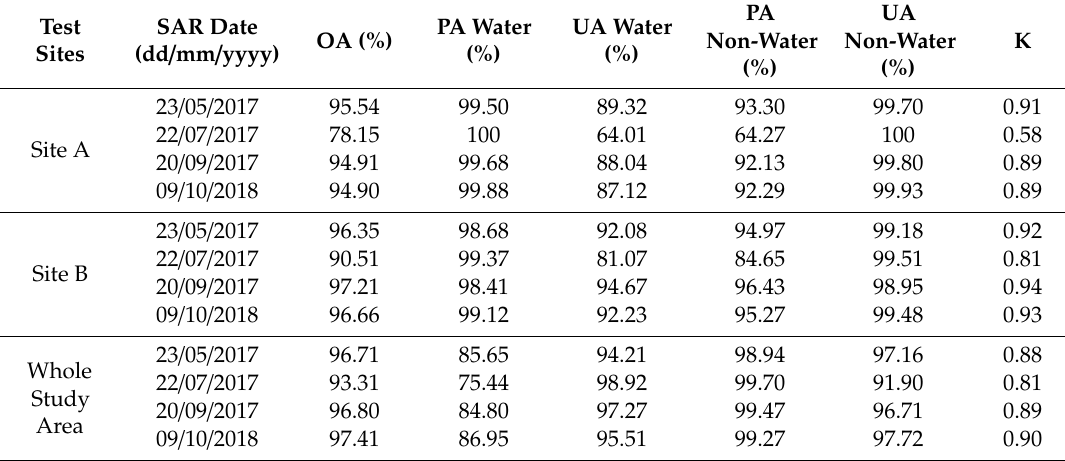
Table 2. Quantitative metric values of the proposed heuristic and automatic water extraction (HAWE) method for two selected test sites and the whole study area